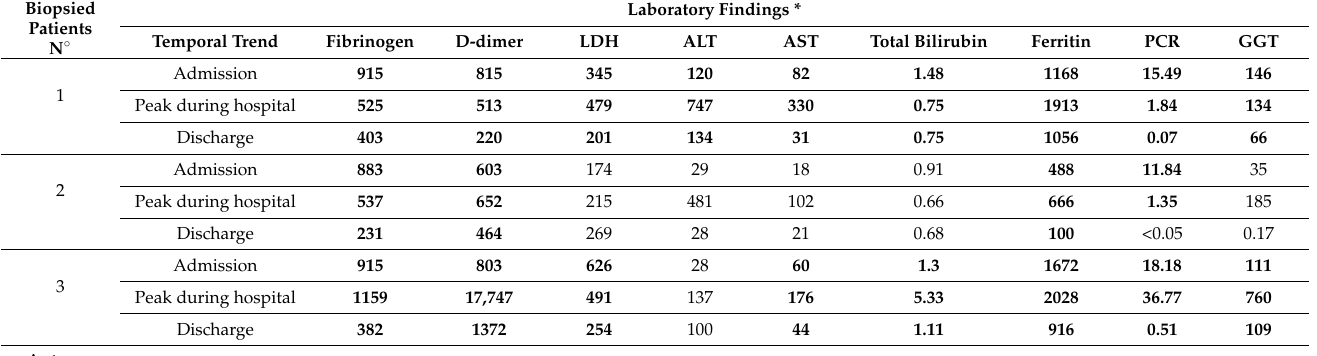
Table 3. Laboratory characteristics of biopsied and autoptic COVID-19 patients. Biopsied Patients